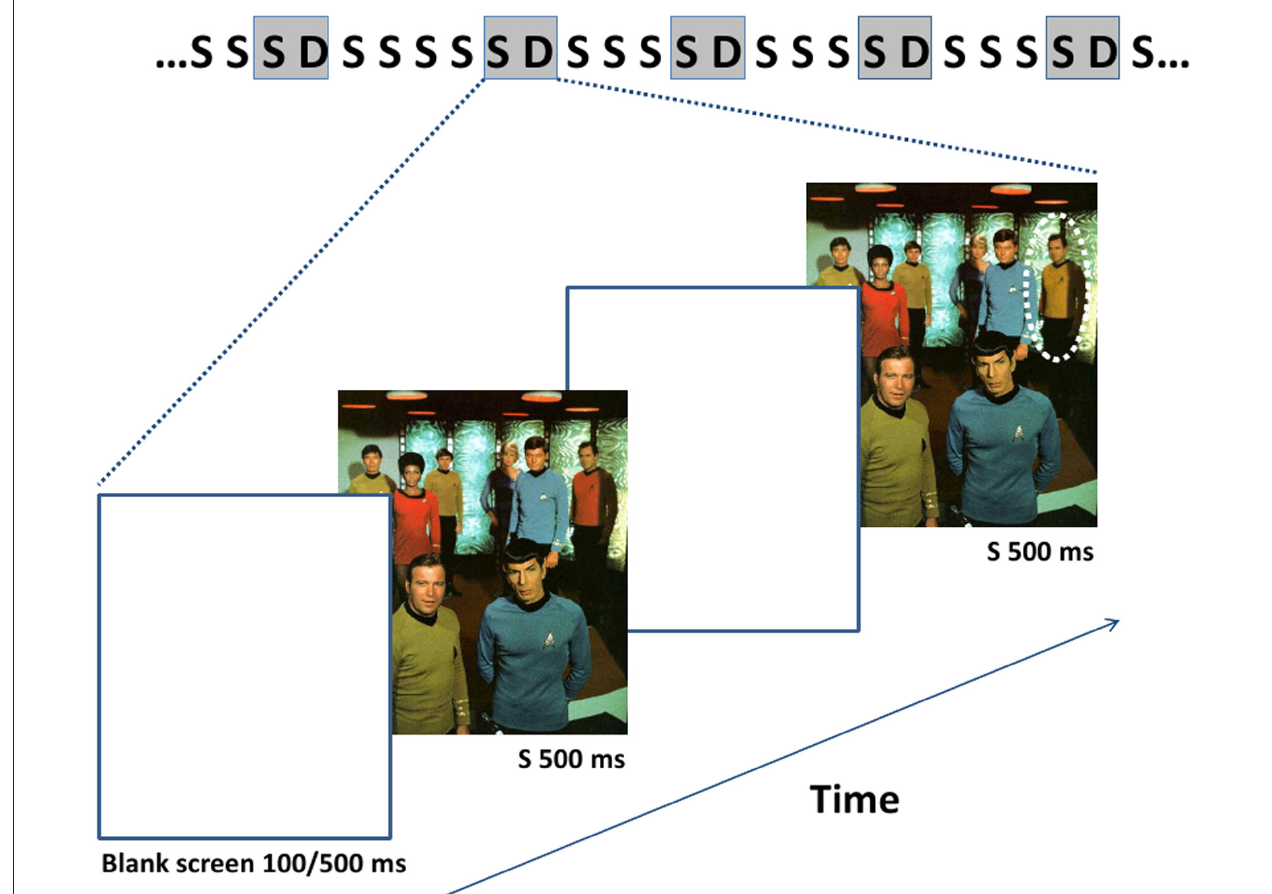
FIGURE 1 | The succession of the stimuli including an example of the images used is depicted uppermost with gray rectangles representing stimuli during which the EEG data were recorded. The probability of the appearance of the standard stimulus was 0.8 and that of the deviant stimulus